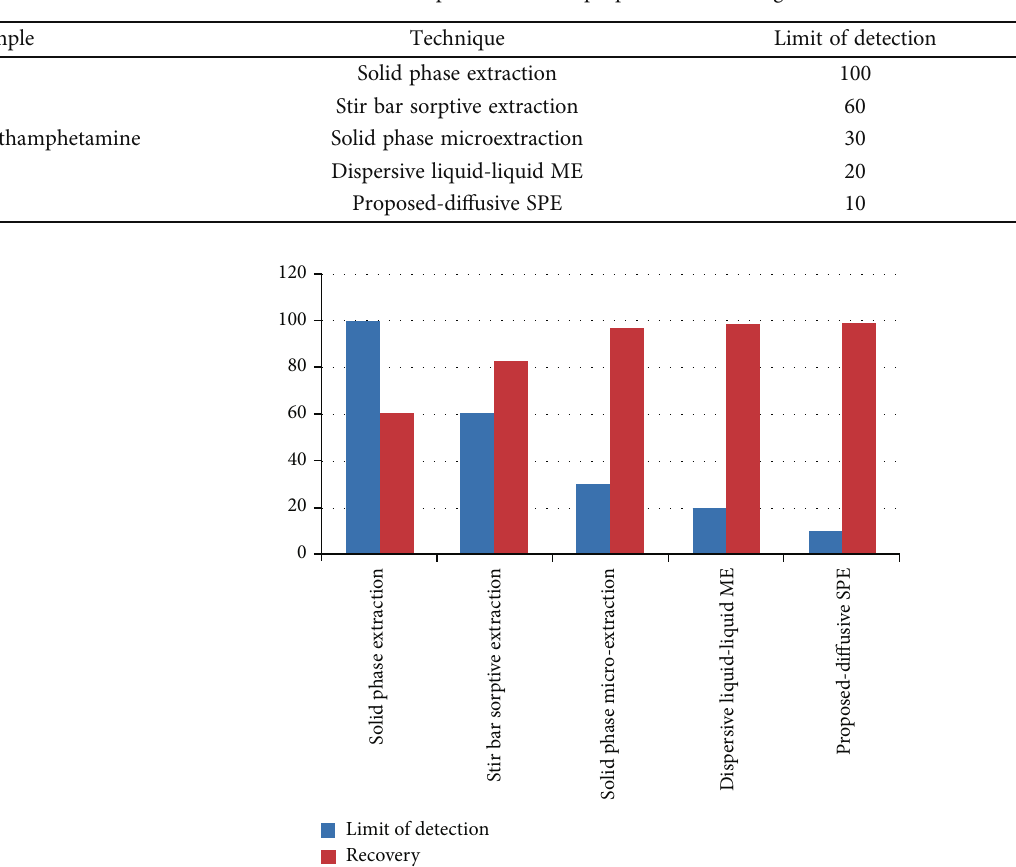
Table 2: Comparison table of proposed and existing methods.